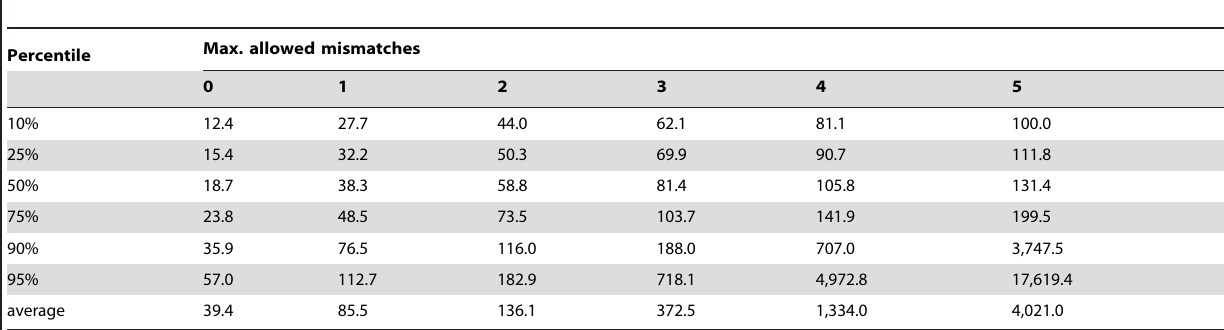
Table 5. Query times for simulated data for k =40 and sparsity =3 (size 13.4 GB).